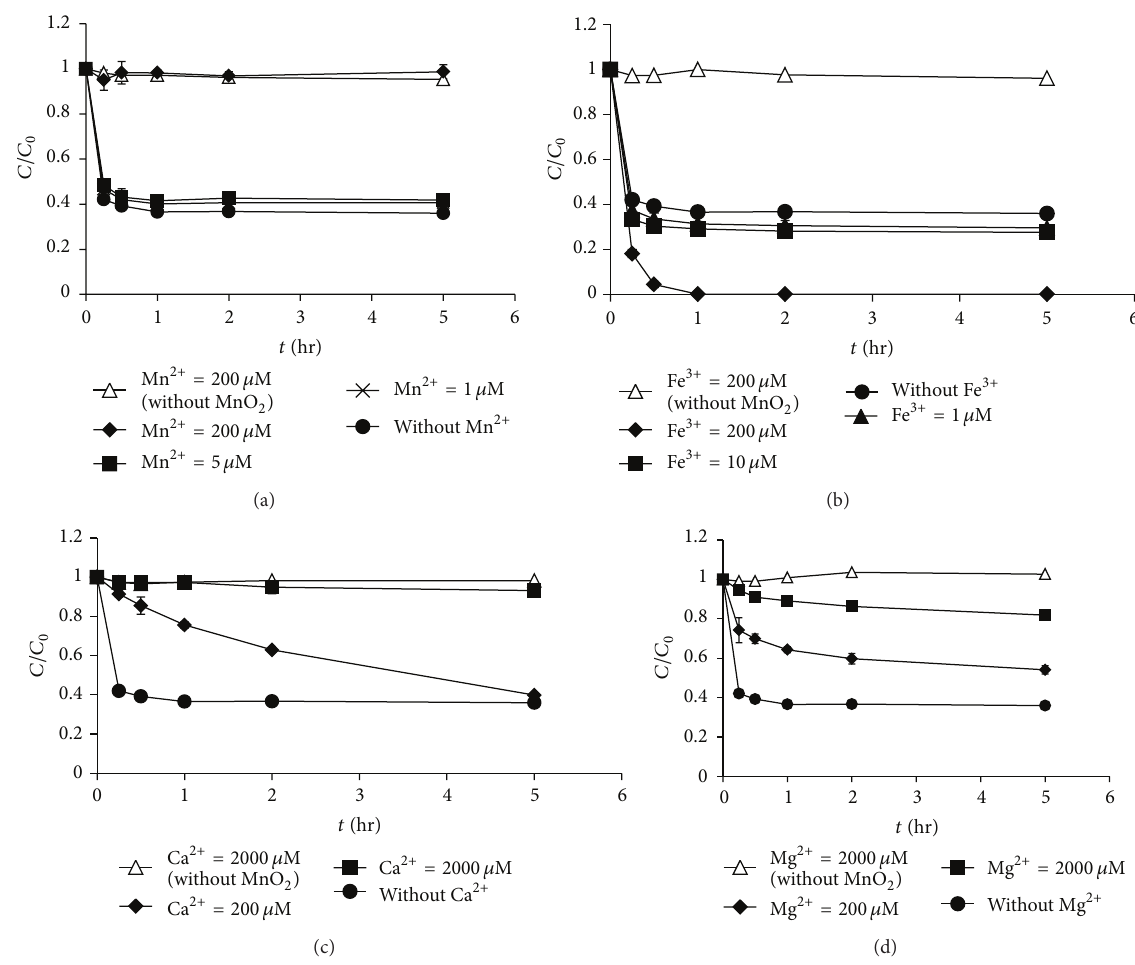
Figure 6: Effect of metal ions on the oxidation of codeine by MnO 2 : (a) Mn 2+ , (b) Fe 3+ , (c) Ca 2+ , and (d) Mg 2+ (MnO 2 loading = 8 mg/L, initial codeine concentration = 100 𝜇 g/L, pH = 7, and ionic strength =